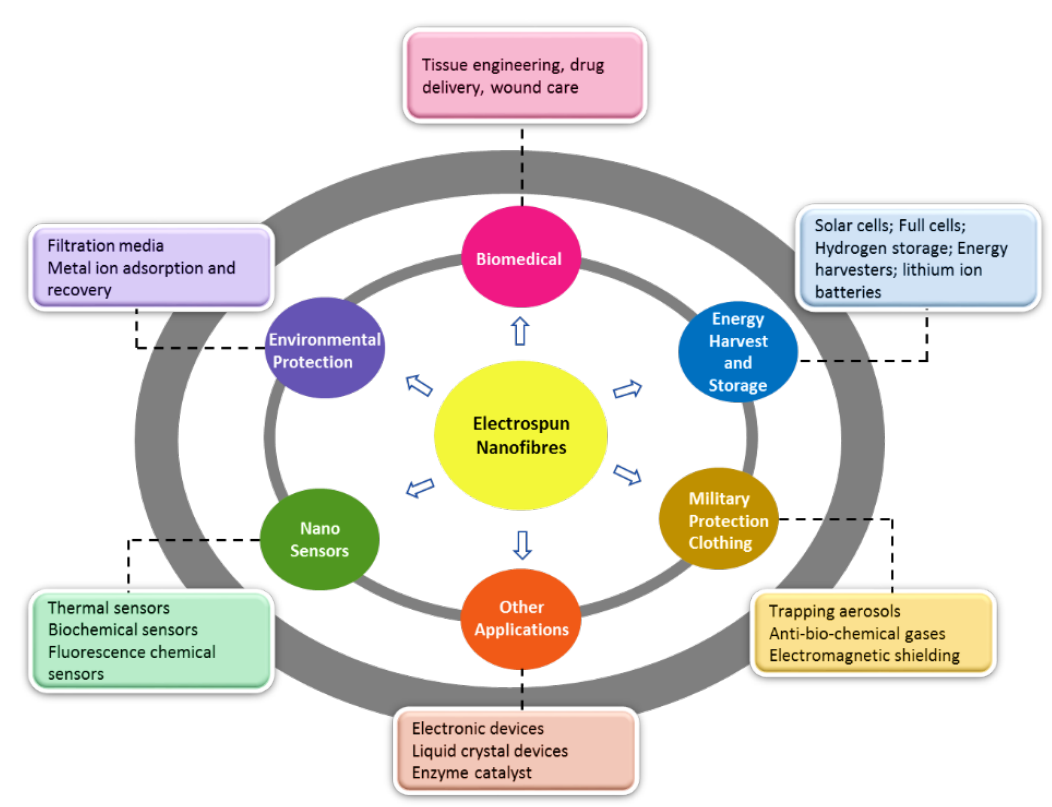
Figure 2. Schematic illustration depicting the various industrial application of electrospinning.